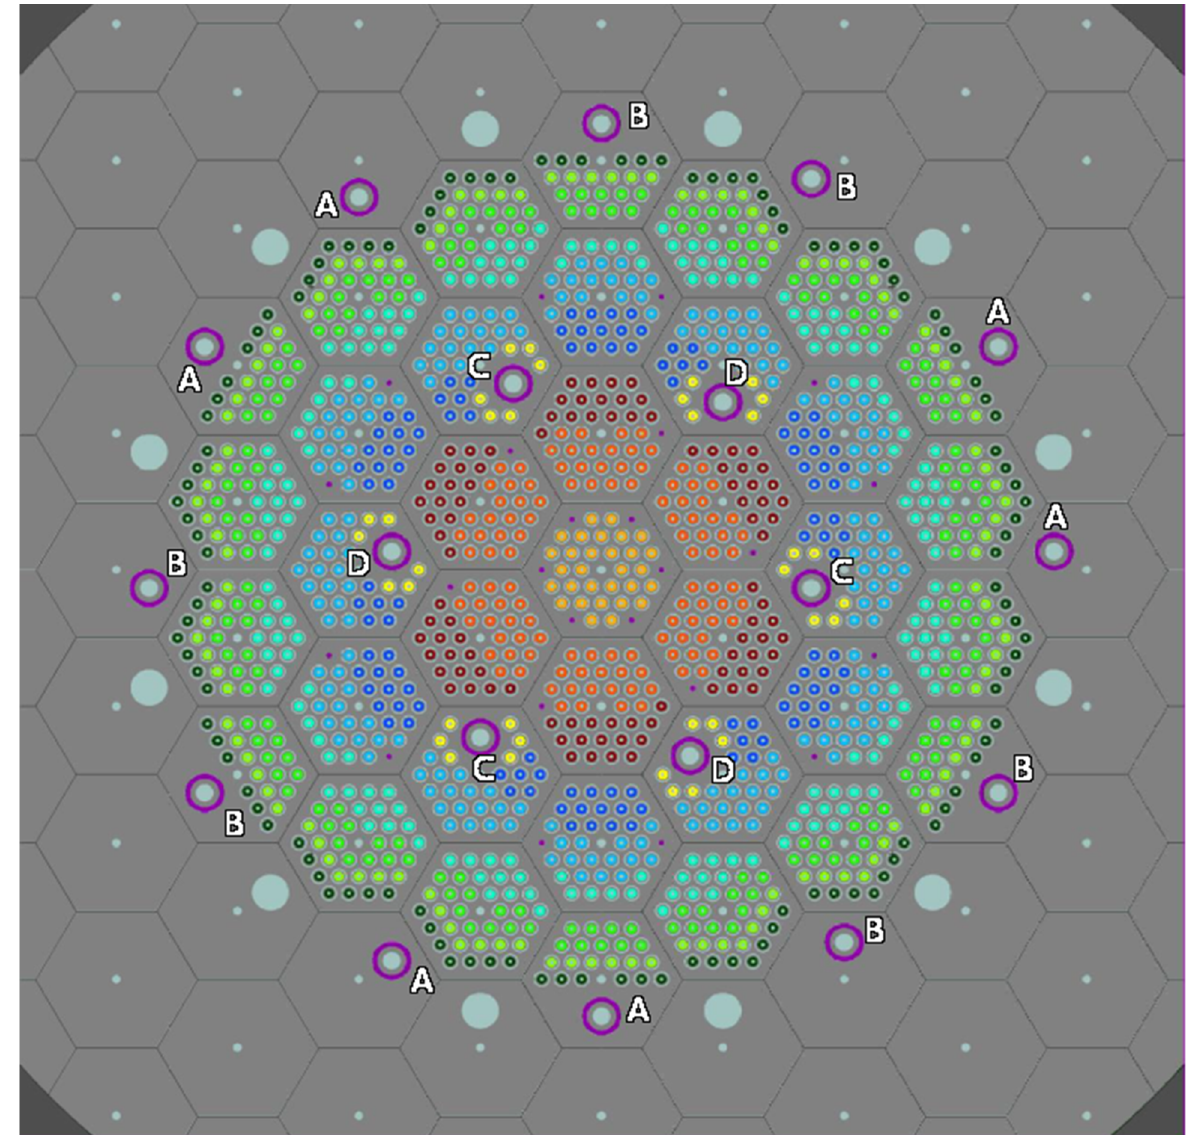
Figure 2. Go_HTR core configuration. Purple rings represent control rods, and purple dots represent burnable poison rods.